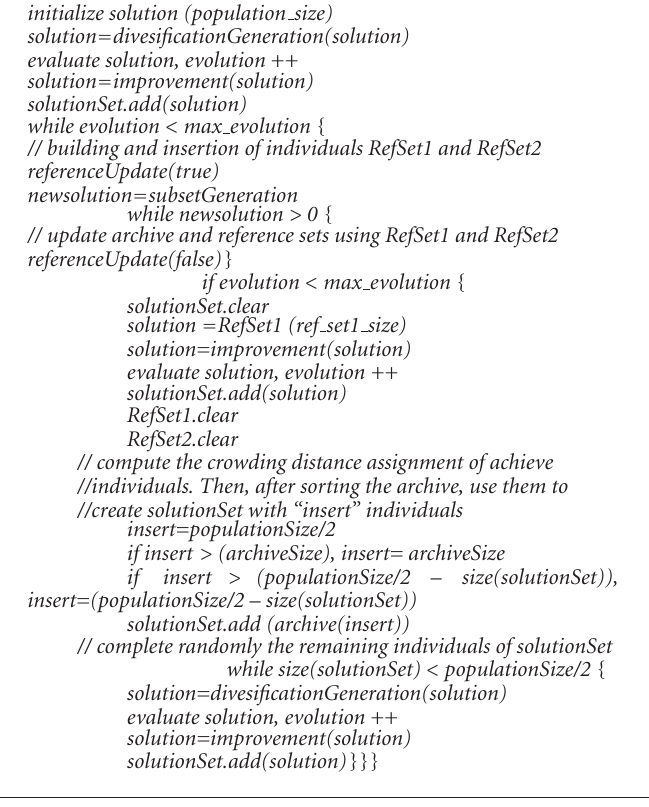
Algorithm 4: A pseudocode for AbYSS procedure.